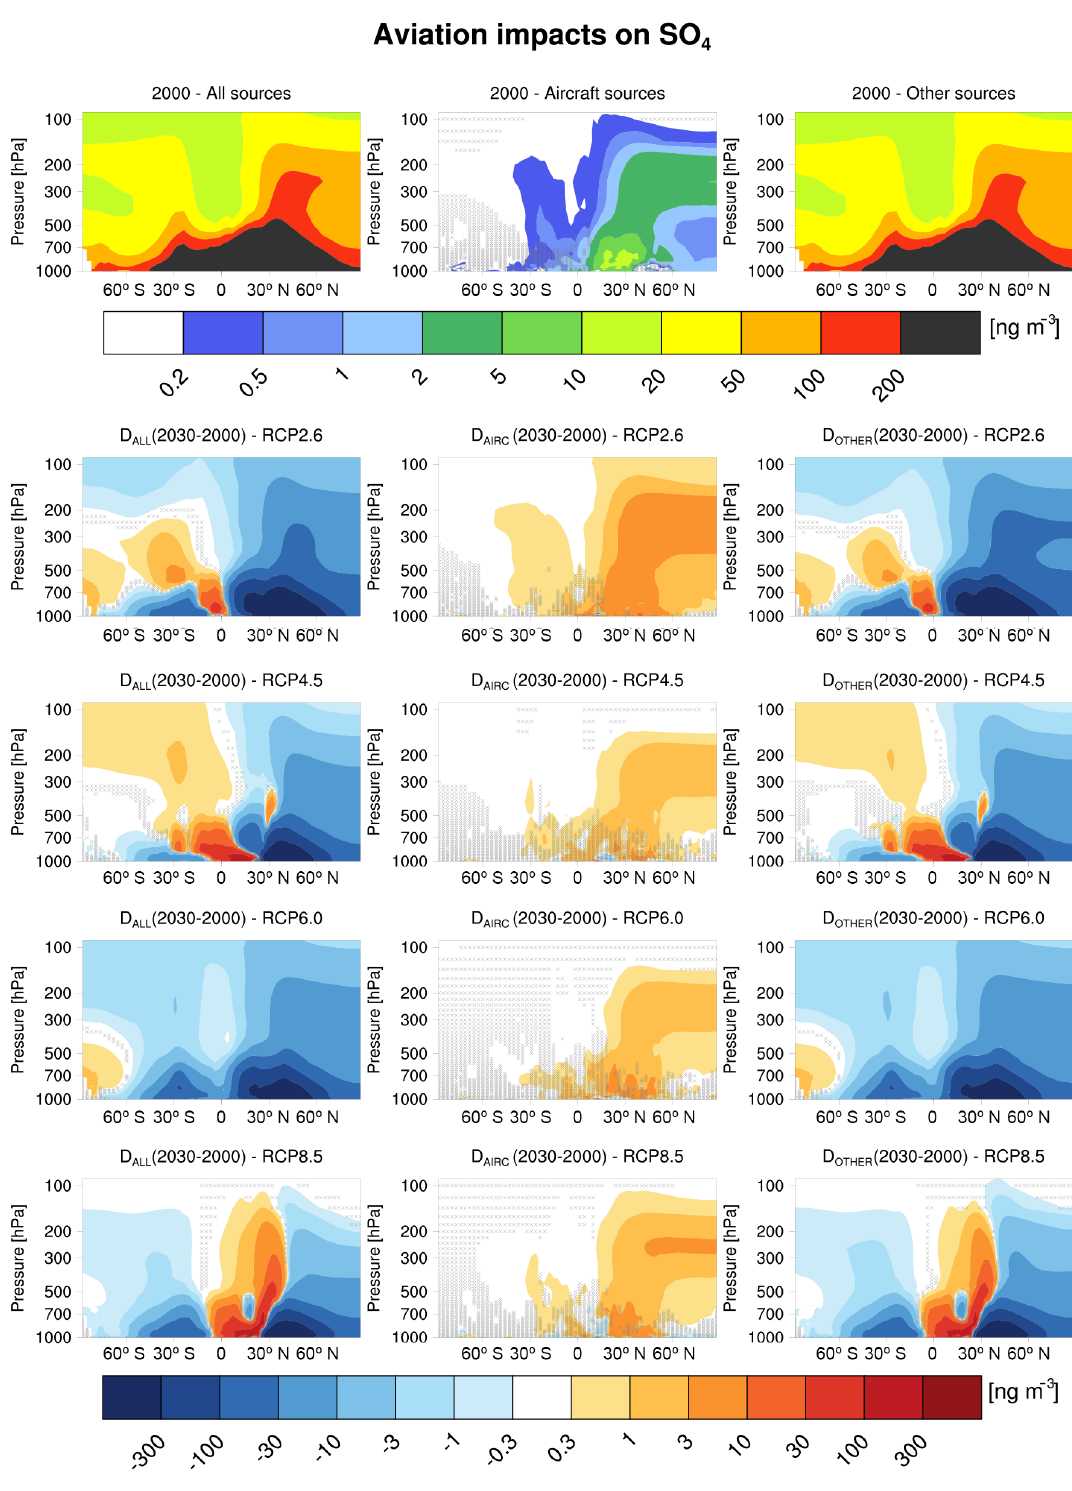
Figure 4. As in Fig. 3 but for aerosol sulfate